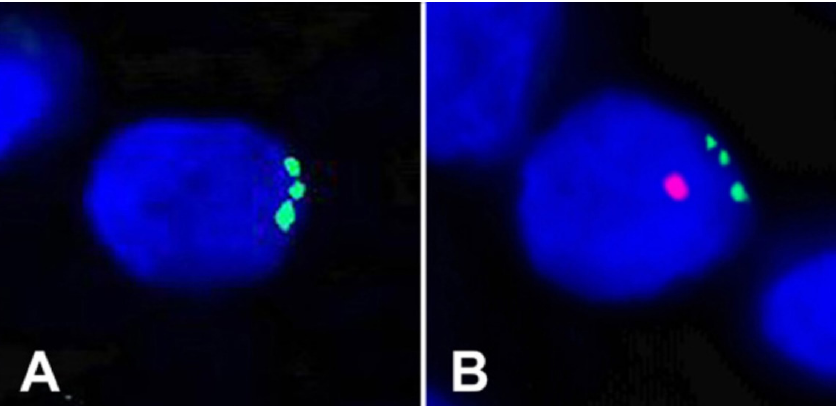
Figure 1. FISH analyses of formalin-fixed sections of a primary renal cell carcinoma described